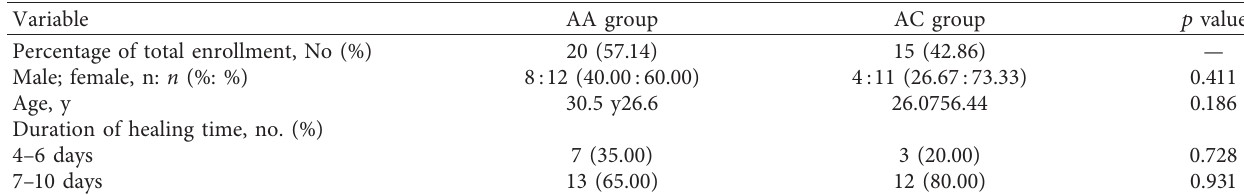
AA, patients treated with aloe vera fermentation gel. AC, patients treated with chitosan